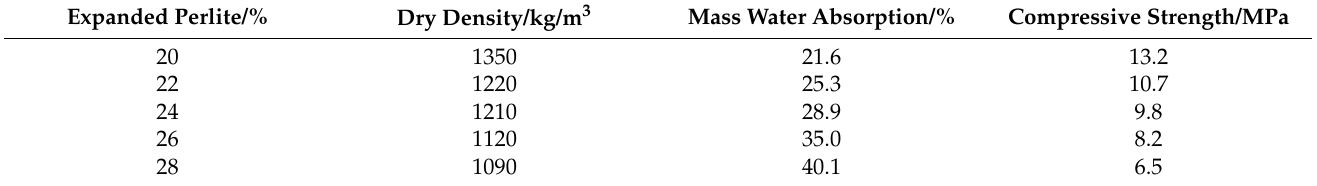
Table 5. Influence of the dosage of expanded perlite on the properties of the mortar.